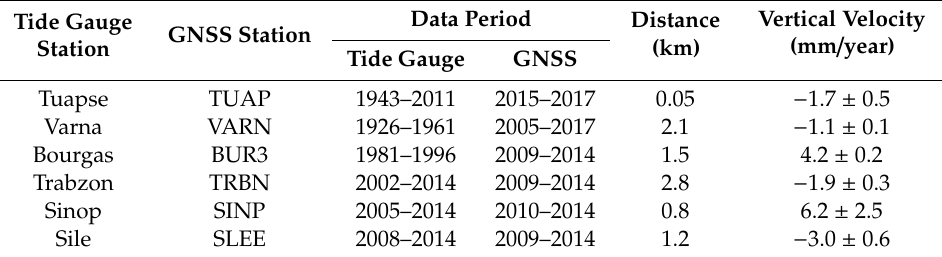
Table 3. Vertical land motions at the tide gauge locations along the Black Sea coast.